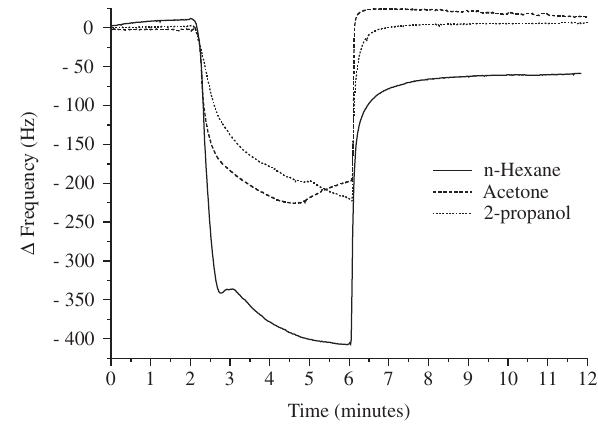
Figure 5. Adsorption tests using QCM